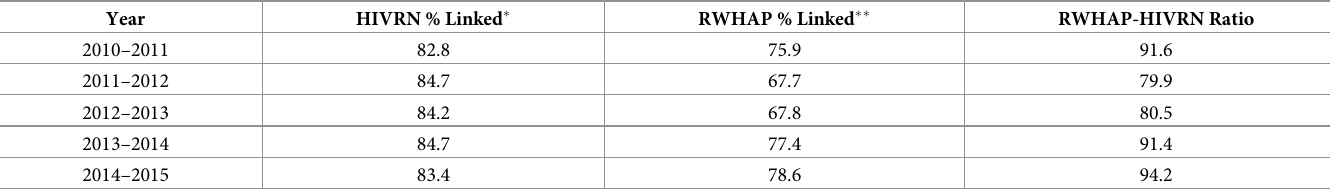
Table 3. Year-to-year HIVRN-RWHAP linkage ratio from 11 matched service providers,